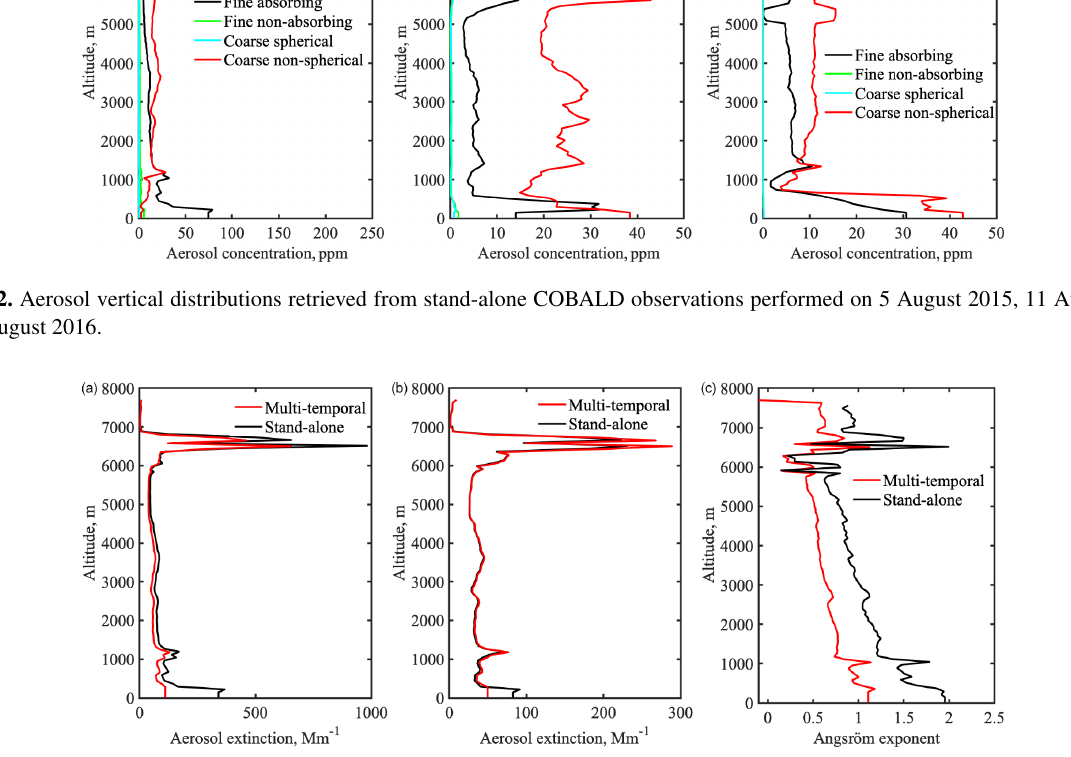
Figure 23. Aerosol extinction profiles at 455nm (a) and 940nm (b) and corresponding Ångström exponent (c) estimated from COBALD profiles acquired on 5 August 2015 using a stand-alone (black) and multi-temporal (red) retrieval schemes.